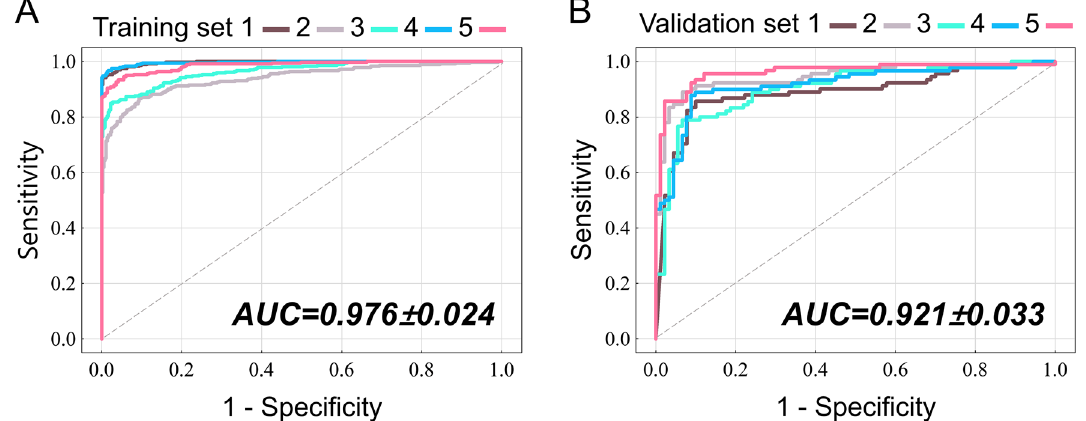
Figure 3. Predictive performance of ANN models. ROC curves with AUCs of the ( A ) training and ( B ) validation sets of ANN model to predict favorable neurological outcomes in cardiac arrest patients who received TTM using baseline parameters of CASPRI score. AUC values are presented as mean ± SD of the five training and validation sets during five-fold cross-validation. ANN artificial neural network, AUC area under the curve, ROC receiver operating characteristic, CASPRI Cardiac Arrest Survival Post-resuscitation In-hospital, TTM targeted temperature management, SD standard deviation.